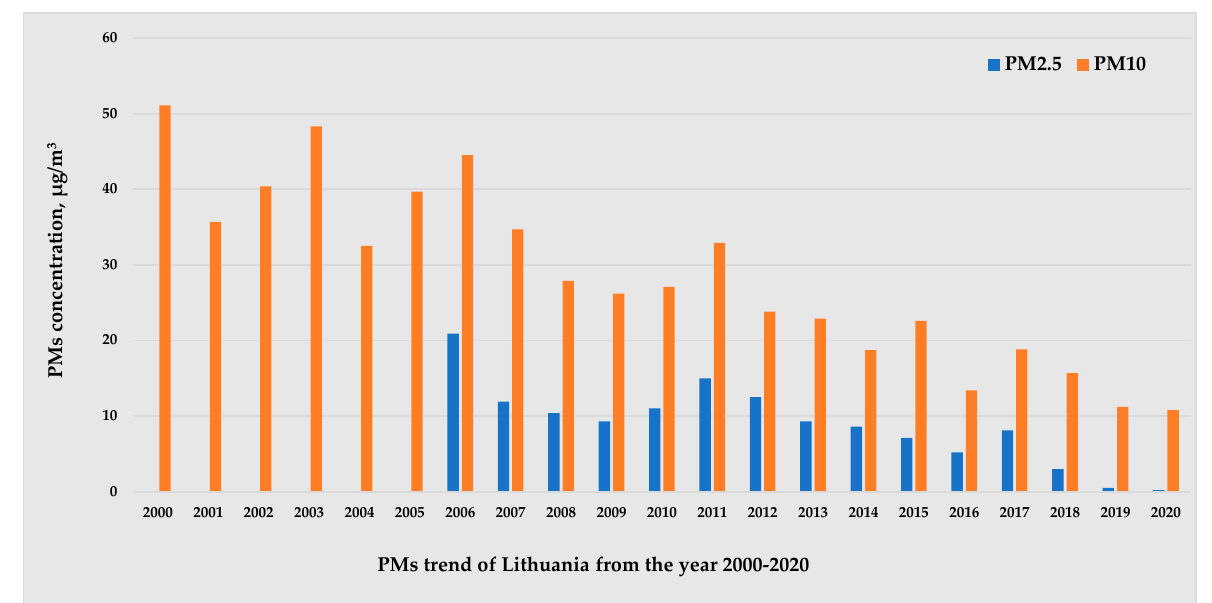
Figure 1. Urban population exposed to air pollutant concentrations above selected EU air quality standards, EU-27.